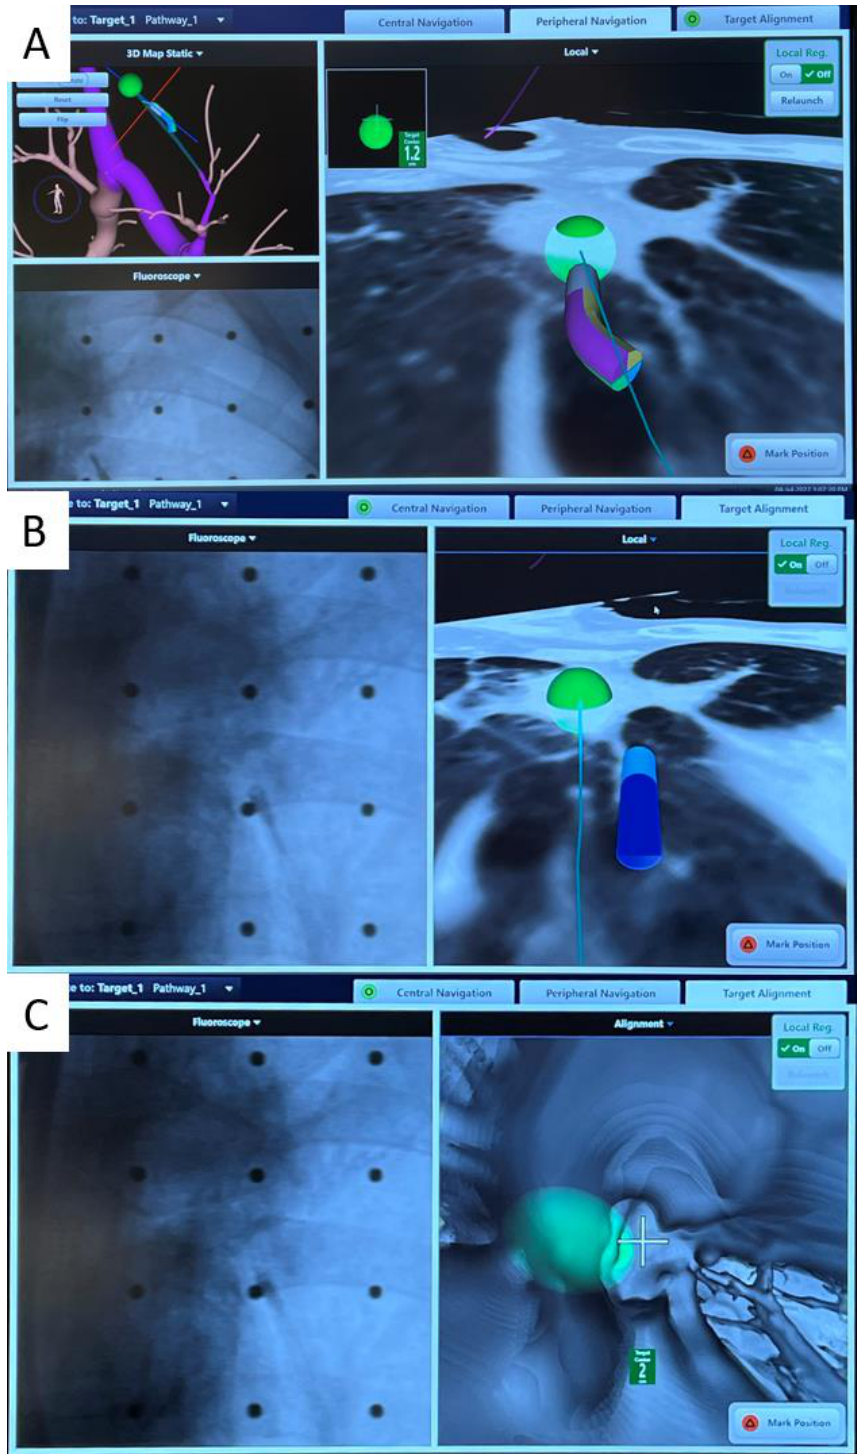
Figure 2. Images during ENB navigation using the Illumisite TM platform. ( A ) Tip of the locatable guide pointing directly at the lesion (represented by the green ball) after peripheral navigation. In ( B ), the locatable guide was removed, but there were positional sensors embedded in the extended working channel which is shown pointing slightly off-center at the lesion. In ( C ), the crosshair is shown, pointing slightly off-center at the lesion which would require further manipulation to ensure target view, while the tip of the catheter is shown to be 2 cm from the target lesion.